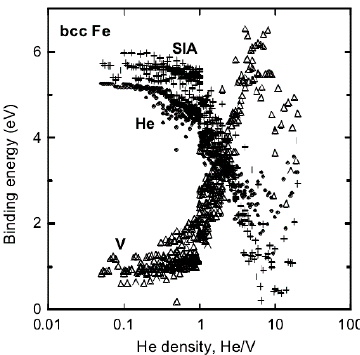
Figure 3. The variation of binding energies of a vacancy, an interstitial He atom and a SIA to He–V cluster with different He density in Fe. Reprinted with permission from [25]; Copyright 2003 Elsevier.